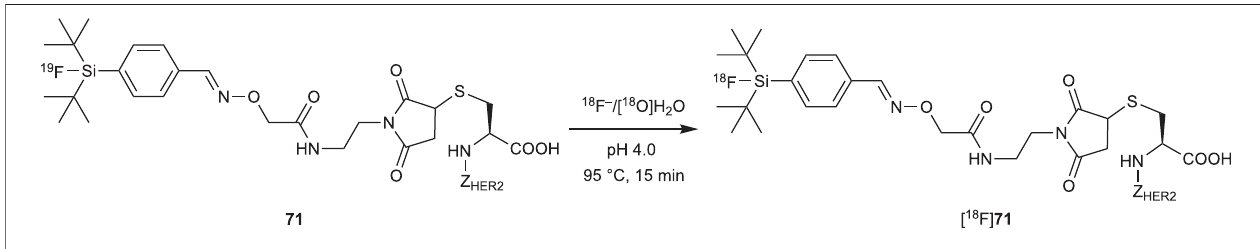
FIGURE 9 | 19 F/ 18 F isotopic exchange has been used to radiolabel the HER2 binding af fi body under aqueous condition. This is the only example of the direct and aqueous fl uorination of a large biomolecule in the chemical literature.